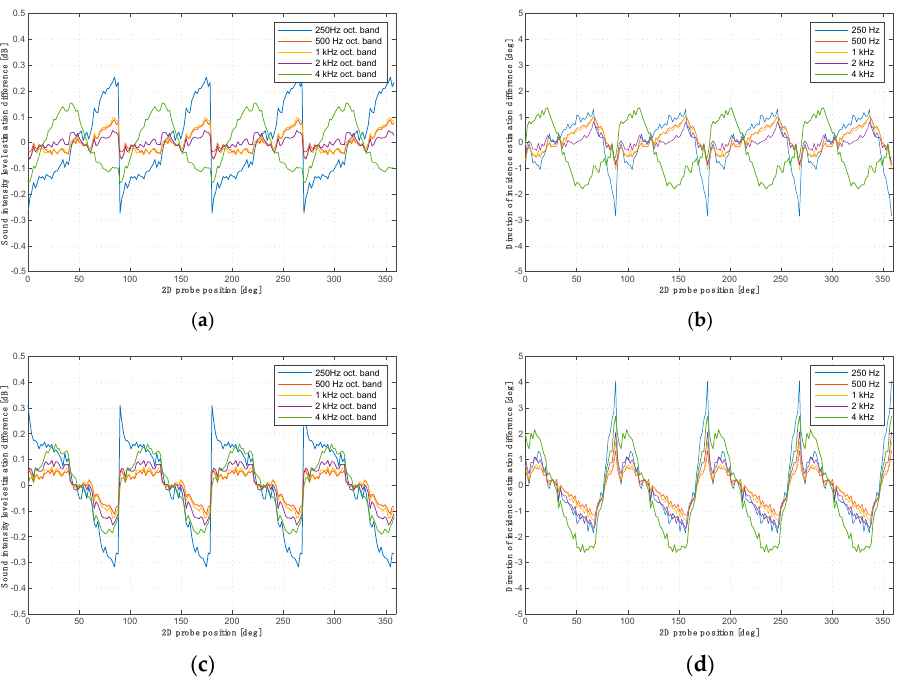
Figure 8. Variations of sound intensity magnitude ( a , c ) and deviation of the indicated angle from the nominal value ( b , d ) for a single-microphone probe for subsequent angular positions of the probe. Microphone 1 ( a , b ); microphone 2 ( c , d ).